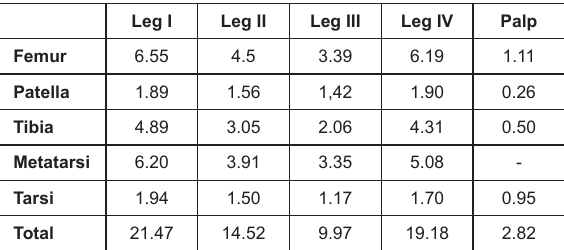
Table 1. Morphometry of legs and palp of female (WILD-11- ARA-1113) from Manipur